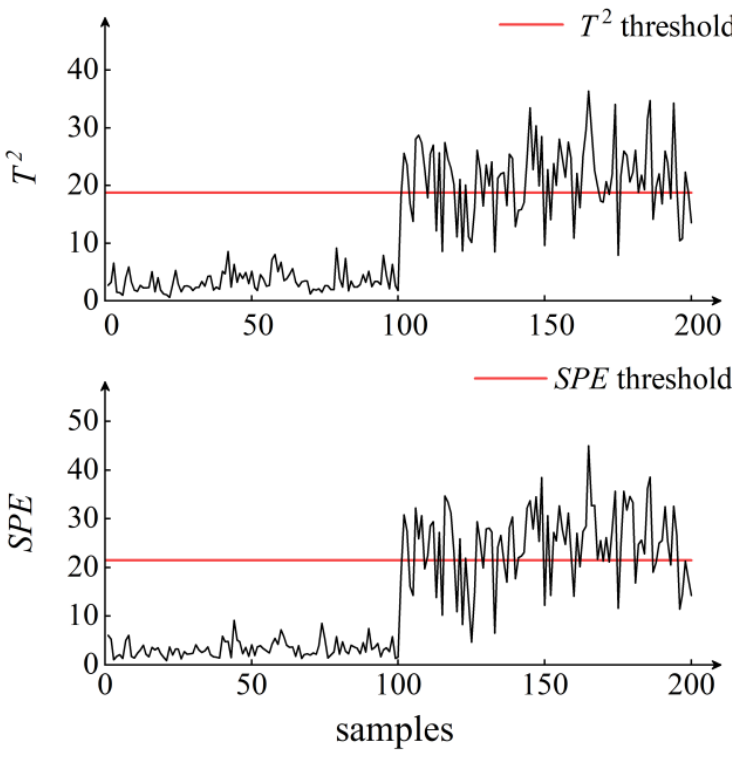
Figure 14. W-PLS monitoring of sample 2.